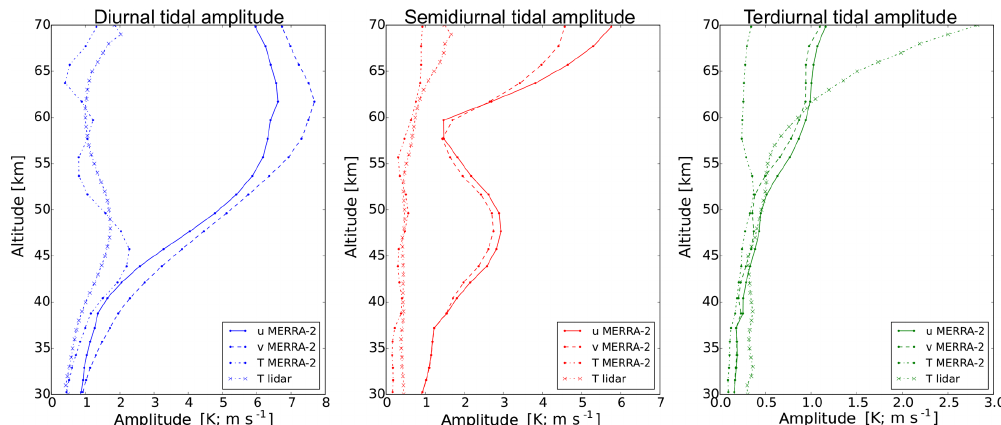
Figure 5. The diurnal (blue), the semidiurnal (red) and the terdiurnal (green) tidal amplitudes derived from the lidar temperature field (dotted line with crosses), from the MERRA-2 zonal wind field (solid line) and from the meridional wind field (dashed line) as mean over all days of the sounding period in May 2016. For comparison the tidal amplitudes from the temperature field of MERRA-2 are also shown (dotted line with points).